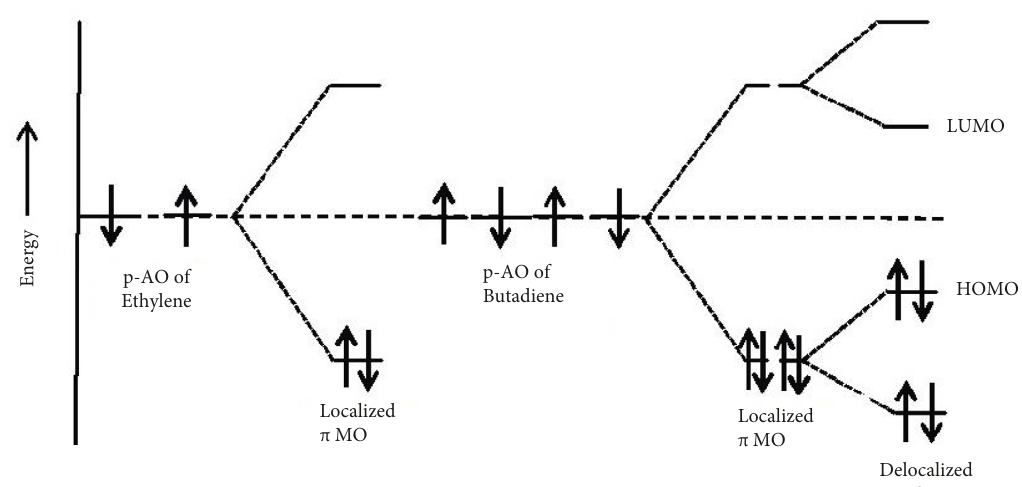
Figure 2: Illustration of π -MO energies for localized and delocalized systems.